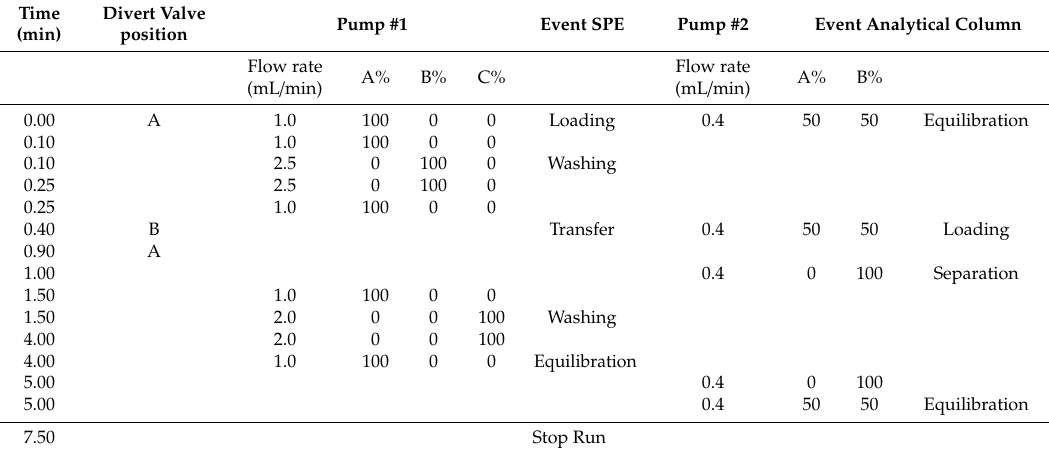
Figure 3. Operation scheme of the valve for online SPE. Table 4. Scheme of online SPE protocol.